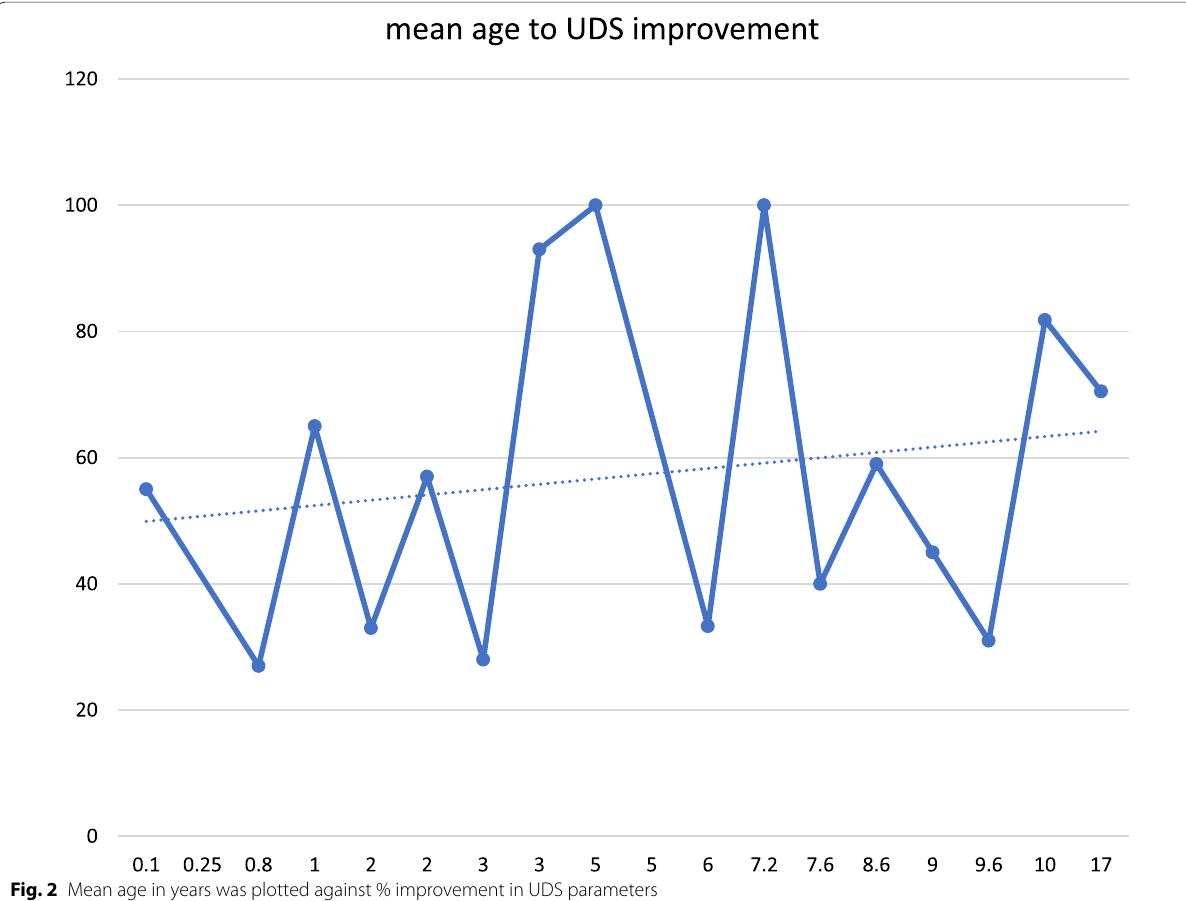
Fig. 2 Mean age in years was plotted against % improvement in UDS